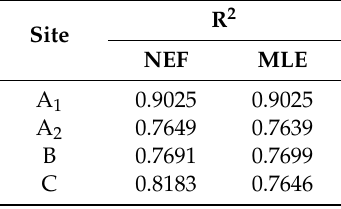
Table 2. Comparison of performance between the nested ensemble filter (NEF) and maximum likelihood estimation (MLE) methods.